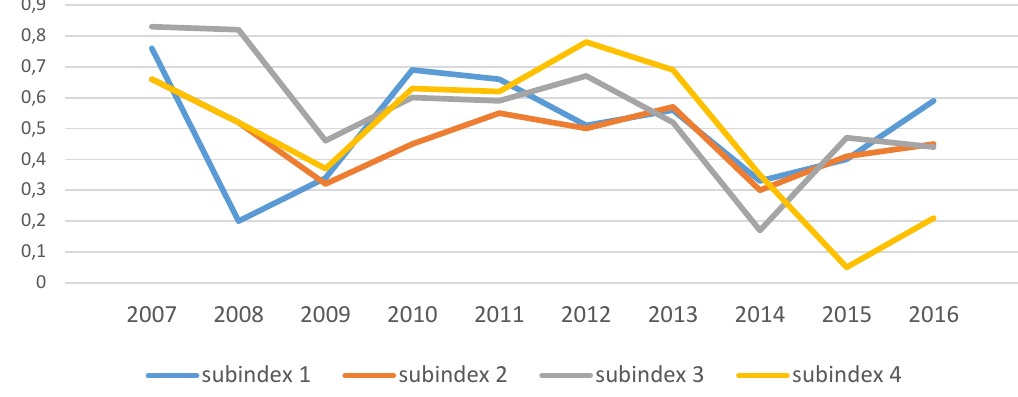
Figure 3. Dynamics of changes in values of components